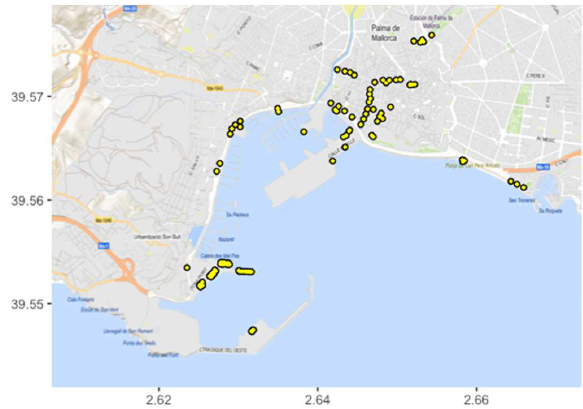
Figure 3. Distribution of Wi-Fi antennas in Palma. Device location data obtained through presence detection mechanisms were gener- ated from the built-in capacities of the installed Cisco Meraki infrastructure [19]. This en- abled presence to be recorded when devices generated probe requests. The uneven distri- bution of the antennas in the city partly determined the selection of study areas.